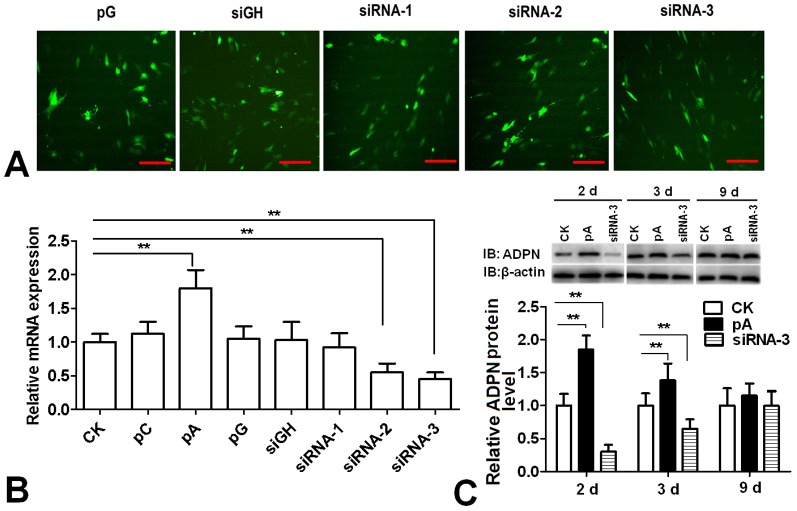
Efficiency detection of adiponectin expression in chicken preadipocytes.(A) GFP observed by fluorescence microscopy 24 h after transfection with pGPU6 recombinant vectors. Scale bar, 100 µm. (B) The expression of adiponectin gene 24 h after transfection with pcDNA3.1-ADPN and pGPU6 recombinant vectors (n = 3). (C) The expression of adiponectin protein at day 2, 3 and 9 after transfection with pcDNA3.1-ADPN and siRNA-3 (n = 3). CK: Control group, pC: pcDNA3.1, pA: pcDNA3.1-ADPN, pG: pGPU6/GFP/Neo, siRNA-1: pGPU6/GFP/Neo-ADPN-676, siRNA-2: pGPU6/GFP/Neo-ADPN-751, siRNA-3: pGPU6/GFP/Neo-ADPN-952, siGH: pGPU6/GFP/Neo- siGAPDH. Values are means ± SEM. vs. control group, * P<0.05, ** P<0.01.